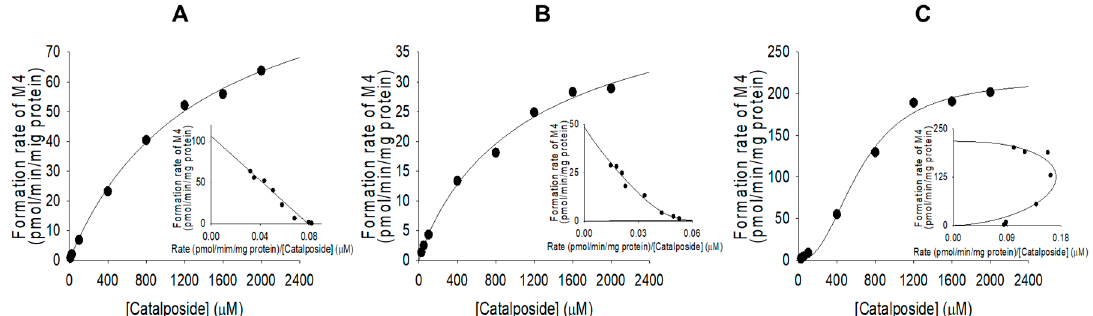
Figure 7. Michaelis–Menten plots for glucuronidation of catalposide to catalposide glucuronide (M4) by pooled human intestinal microsomes ( A ) and human cDNA-expressed UGT1A8 ( B ) and UGT1A10 ( C ). Insets: Eadie–Hofstee plots. Each data point represents the average of two determinations. 4-Hydroxybenzoic acid (M2) was formed from catalposide by pooled human liver S9 fractions; intestinal microsomes; and the CES1b, CES1c, and CES2 enzymes (Figure 8). The rate of formation of 4-hydroxybenzoic acid (M2) after incubation of catalposide with pooled human intestinal microsomes was higher than that after incubation with pooled human liver S9 fractions (Figure 8).